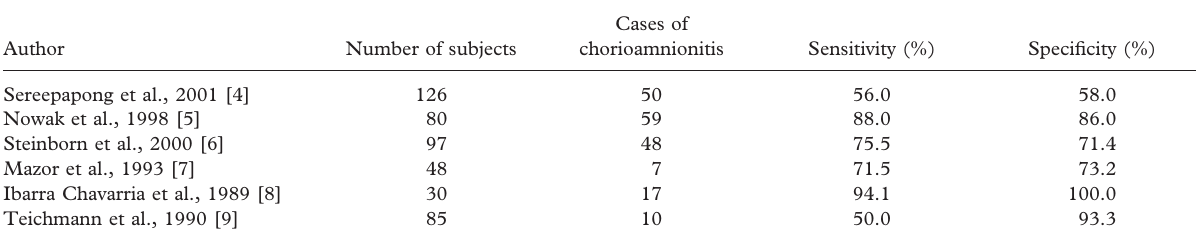
Table III. Sensitivity and specificity in previous reports on diagnostic properties of maternal serum CRP measurement compared with histological or microbiological investigations in detection of chorioamnionitis.